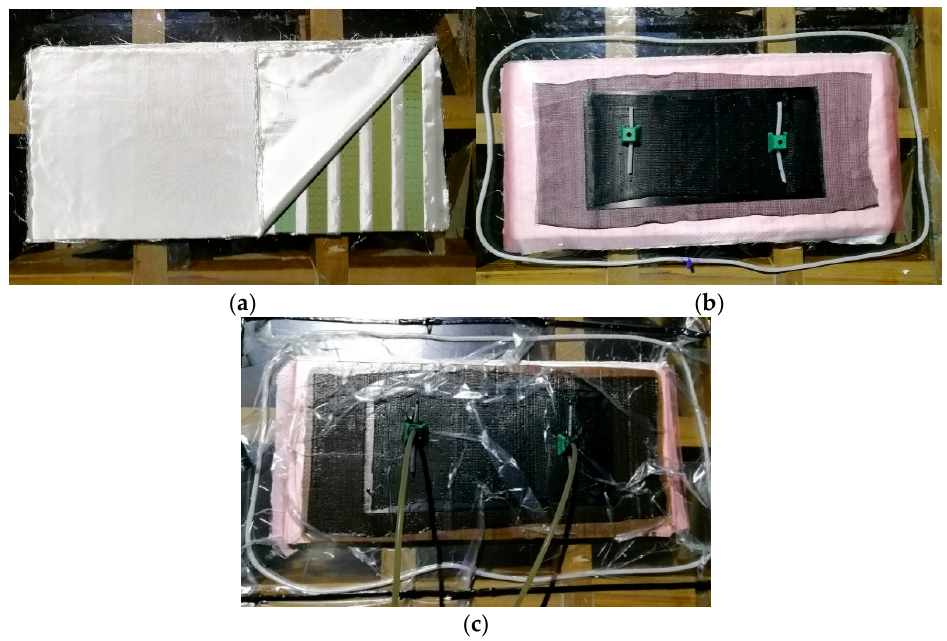
Figure 2. Preparation process of double-layer corrugated plate: ( a ) fiber laying; ( b ) auxiliary material laying; ( c ) resin injection.